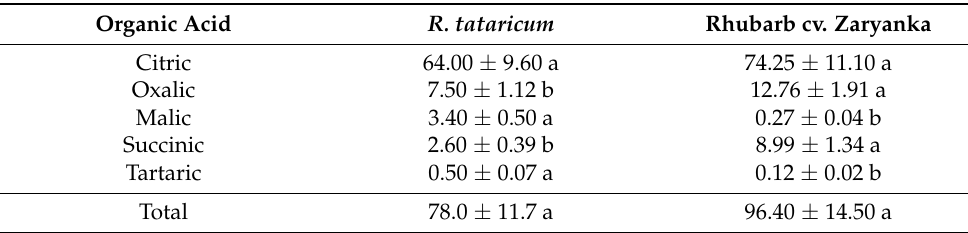
Table 3. Organic acids content in dry Rhubarb stems (mg g − 1 d.w.). Organic Figure 5. Nitrates ( A ) and total dissolved solids (TDS) ( B ) accumulation in R. tataricum and garden rhubarb cv. Zaryanka. Values with the same letters do not differ statistically according to Duncan’s test at p < 0.05.